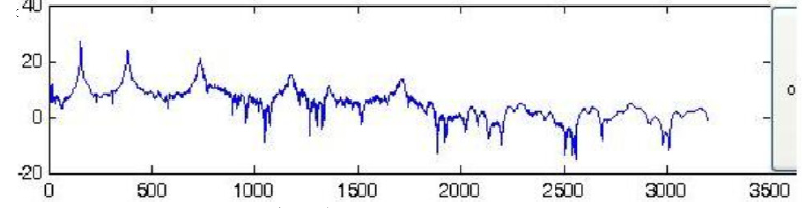
Fig. 3. Fast Fourier Transform (FFT) spectrum showing the first three modes of vibration. Y axis is corresponding to the amplitude in Db, and X axis to the frequency in Hz